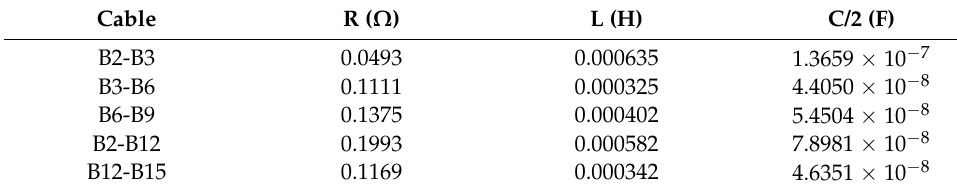
Table A2. Cable parameters: 5-turbine wind power plant.